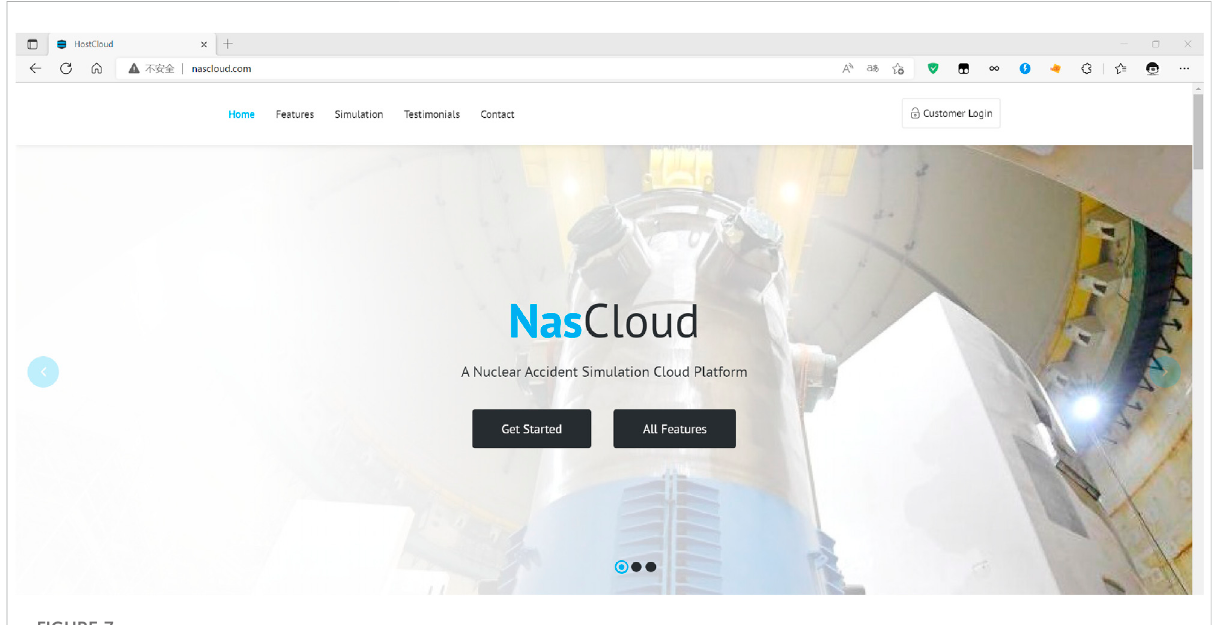
Homepage of the NasCloud.